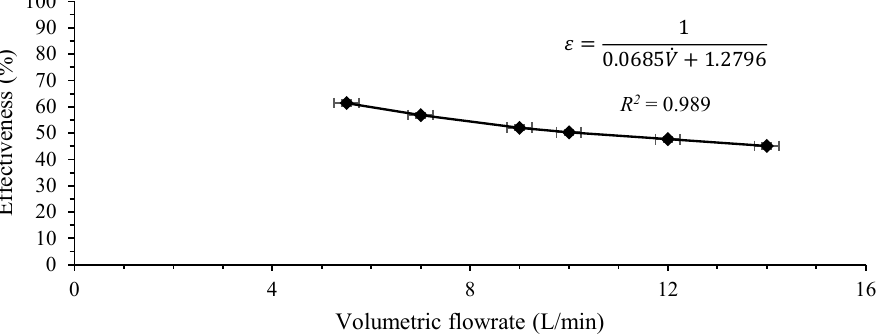
Figure 3. Equal-flow effectiveness vs. volumetric flowrate for a 7.6 cm diameter, 153 cm long DWHR heat exchanger.